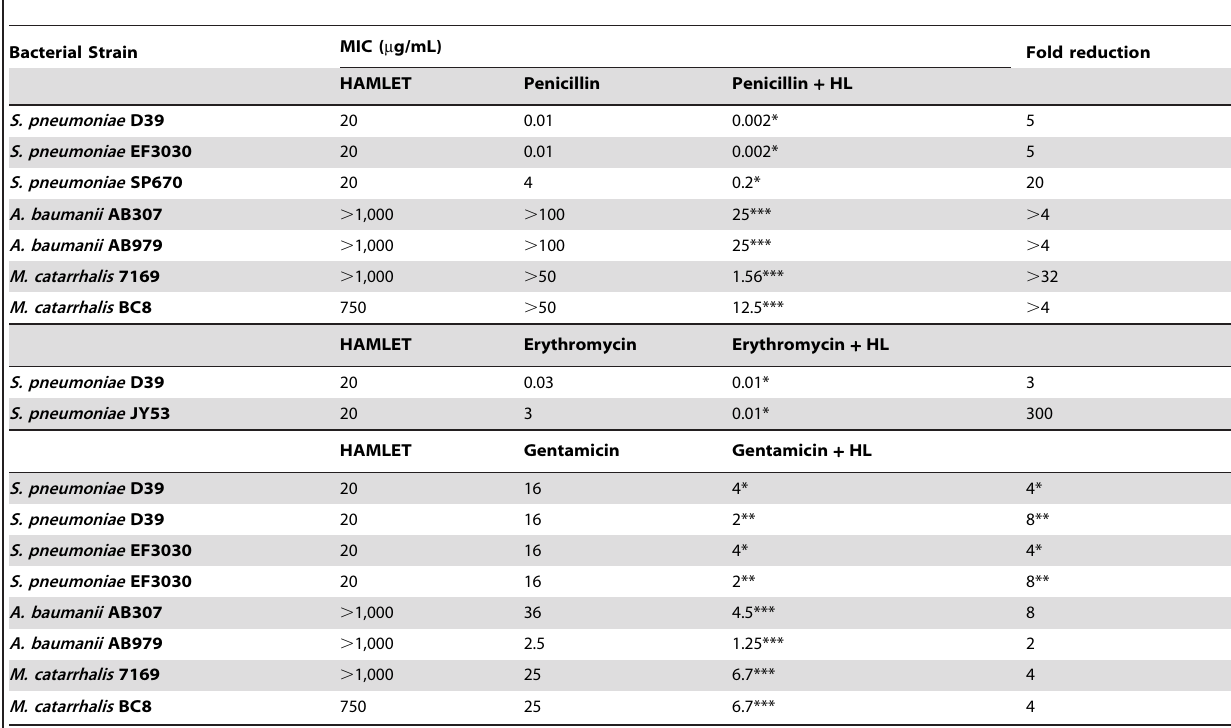
Table 1. MIC determination of HAMLET/antibiotic combination therapy.